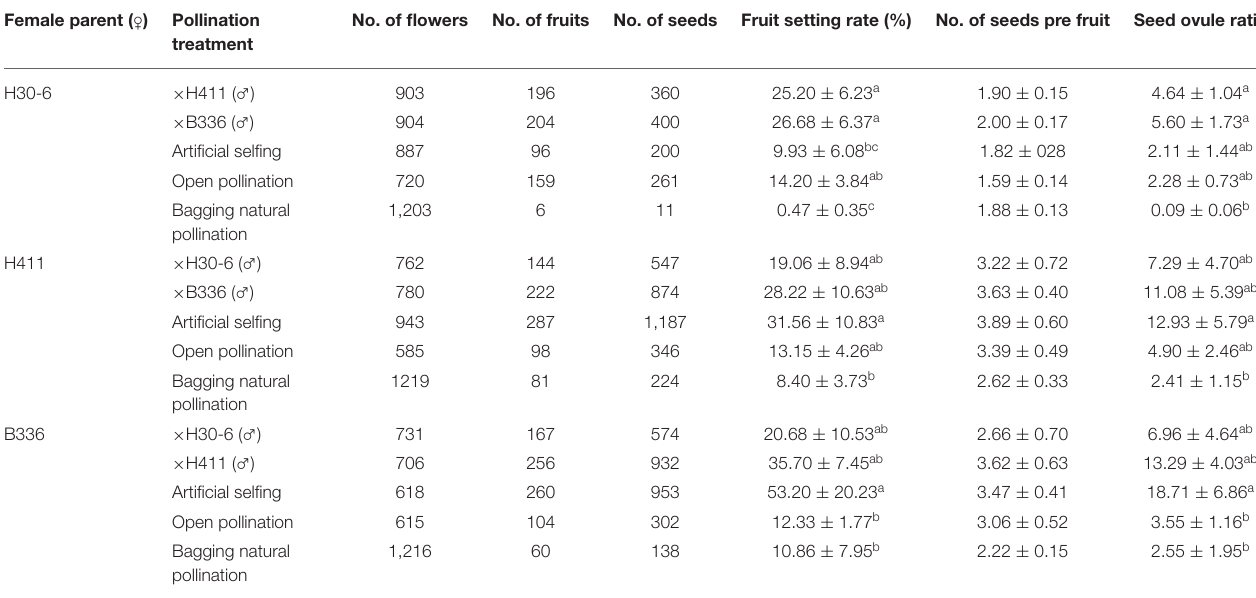
TABLE 4 | The continuous years of pollination treatments results (2018 to 2021). Female parent ( ♀ ) Pollination